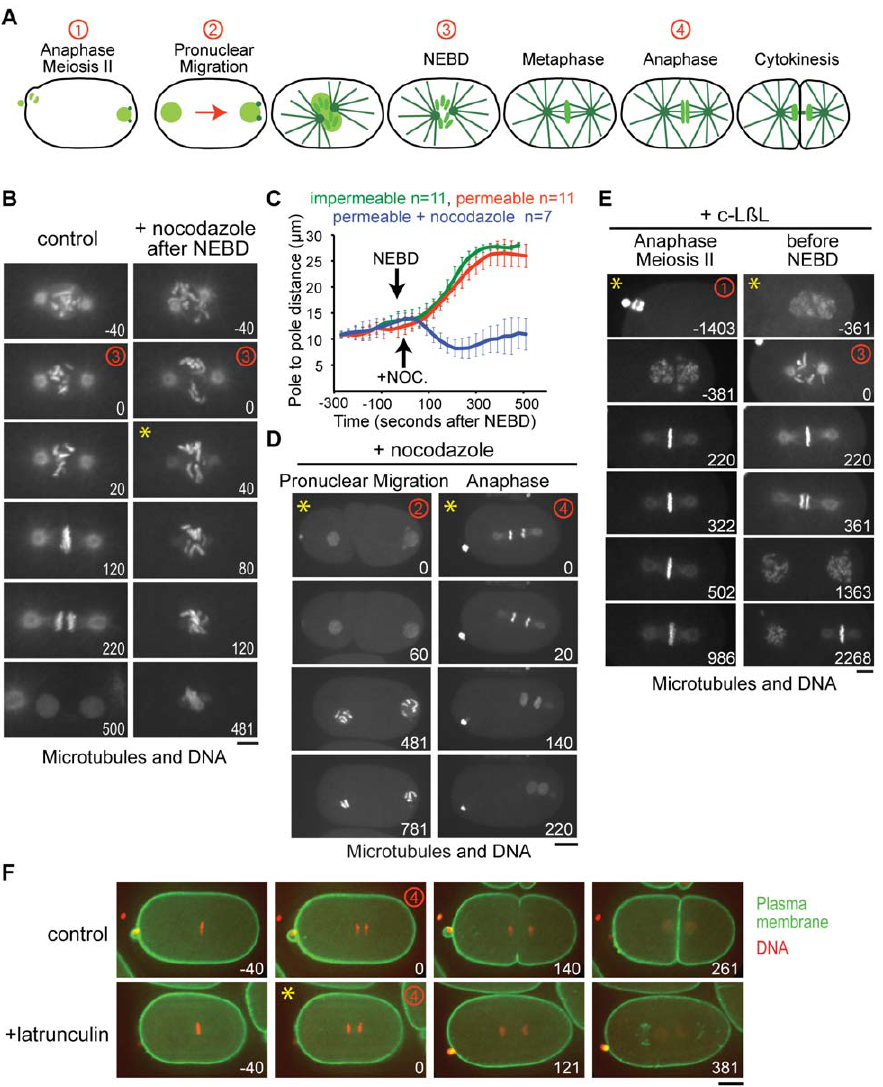
Figure 4. Acute drug treatments with nocodazole, latrunculin A, and c-lactocystin-ß-lactone. A. Schematics illustrating the stages between anaphase meiosis II and cytokinesis of the first mitotic division following fertilization. Red numbers mark the timepoints highlighted in the panels in B, D, E and F. B. Confocal images of permeable embryos expressing GFP-histone H2B and GFP-alpha-tubulin. A control embryo ( left ) and an embryo treated with 10 m g/ml nocodazole after NEBD ( right ) are shown. Addition of nocodazole results in rapid microtubule depolymerization. Numbers in white indicate time in seconds after NEBD. Scale bar, 5 m m. C. Mean pole-to-pole distance plotted versus time for the indicated conditions. Embryos treated with nocodazole after NEBD exhibit a rapid reduction in pole-to-pole distance due to microtubule depolymerization. Error bars are the 95% C.I. of the mean. D. Images of permeable embryos expressing GFP-histone and GFP-alpha-tubulin. Nocodazole was added during pronuclear migration ( left ) or in early anaphase ( right ). In both cases, rapid microtubule depolymerization was observed. Scale bar, 10 m m. Numbers in white indicate time in seconds after the timepoint when drug was added. E. Images of permeable embryos expressing GFP-histone H2B and GFP-alpha-tubulin. The proteasome inhibitor, c-lactocystin-ß-lactone (20 m M) was added either early (anaphase of meiosis II; left ) or just before NEBD ( right ). If added early, the embryo arrested at the first metaphase. If added before NEBD, the metaphase-anaphase transition was delayed, but the embryo did not arrest until metaphase of the second division. Scale bar, 5 m m. Numbers in white indicate time in seconds after NEBD of the first mitotic division. F. Images of embryos expressing a GFP-labeled plasma membrane probe and RFP mCherry -histone H2B. Latrunculin A (10 m M) added after anaphase onset prevented cleavage furrow ingression. Scale bar, 10 m m. Numbers in white indicate time in seconds after anaphase onset. Yellow asterisks in the upper left corner of the panels in B, D, E and F mark the time point when drug was added.